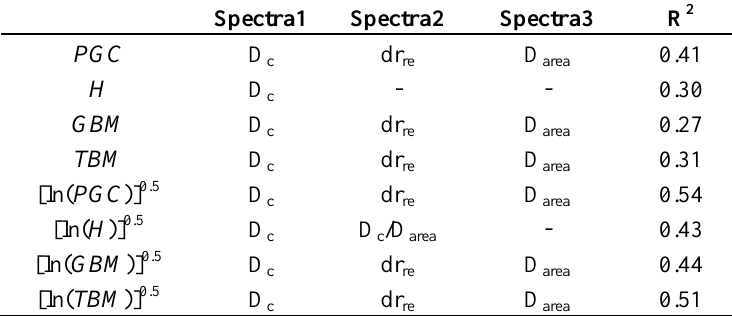
2. Empirical models and performances from stepwise regressions using continuum-removed spectra and dr to estimate canopy properties ( n = re